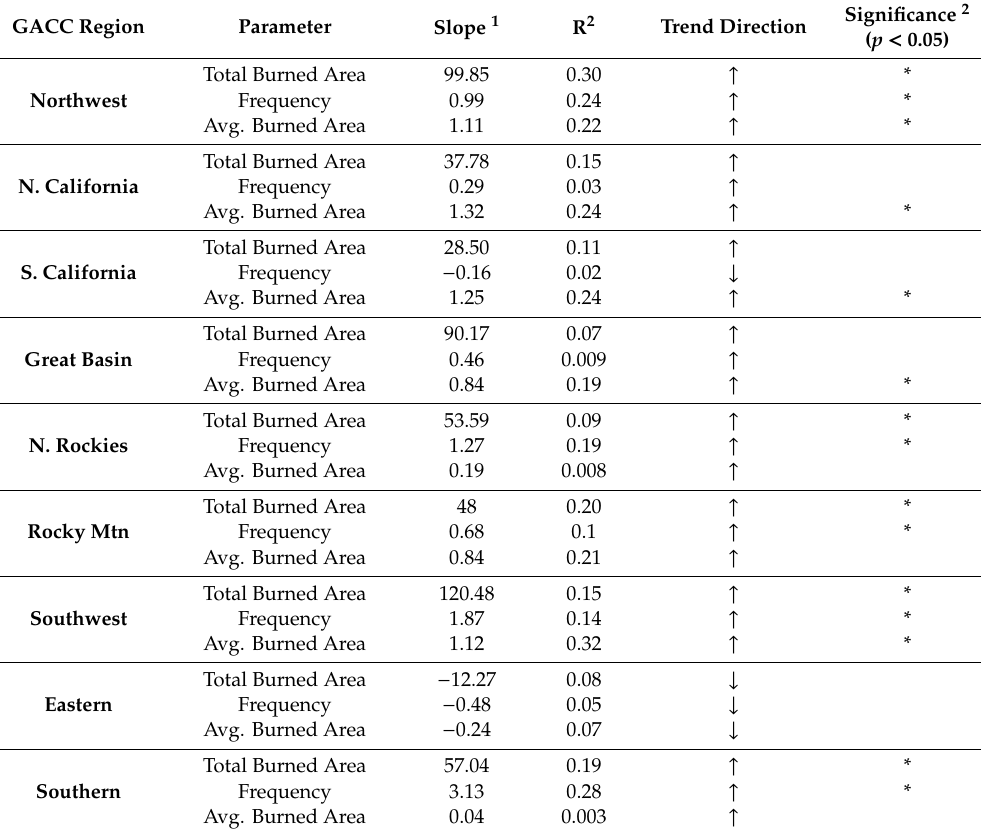
Figure 3. ( a – i ) Time series of the nine GACC regions (1984–2017) for the parameter of total burned area per year. Each time series is fitted with a trend line, in red, using linear regression techniques (least-squares method). Table 2. Characterization of the nine GACC regions based on the metrics of the three parameters